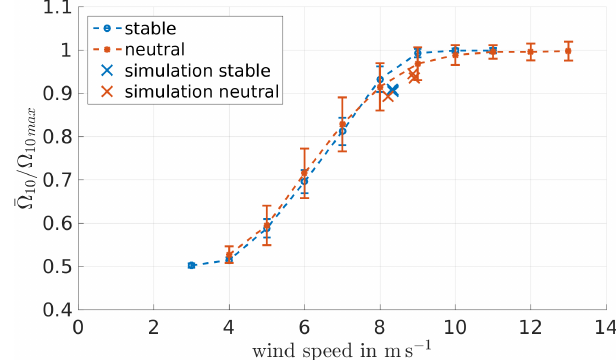
Figure 20. Relation between the rotor speed (cid:127) , normalised with the maximum measured rotor speed with an added offset, with re- spect to the wind speed determined using the measurement data in comparison to the simulation data ( ×